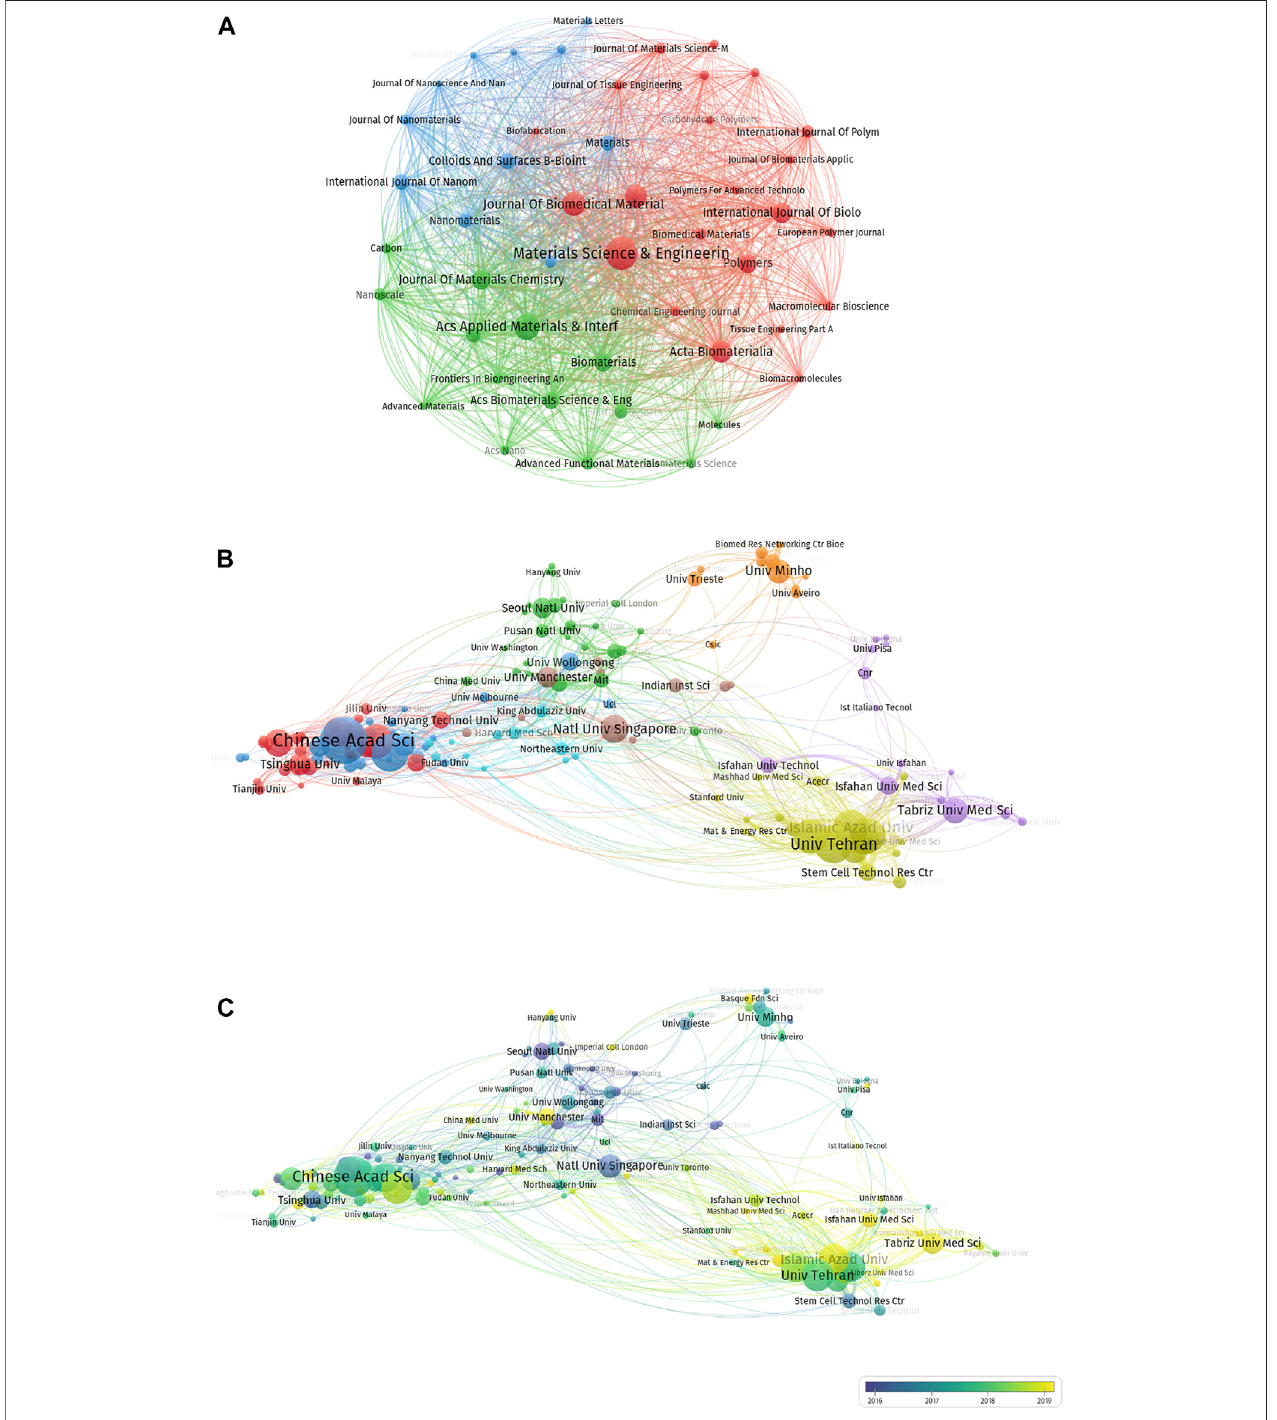
FIGURE6| ThedistributionofjournalsandinstitutionsengagedinresearchonelectroactivebiomaterialsusedinTE. (A) Top10journalsbynumberofpublications, blue bar representing the proportion and red bar representing IF; (A) . The network of relationships between with different journals in VOSviewer. (B) The network of institutions produced in VOSviewer. The size of the circles reveals the number of publications; (C) Concentrated years of publications for different countries.